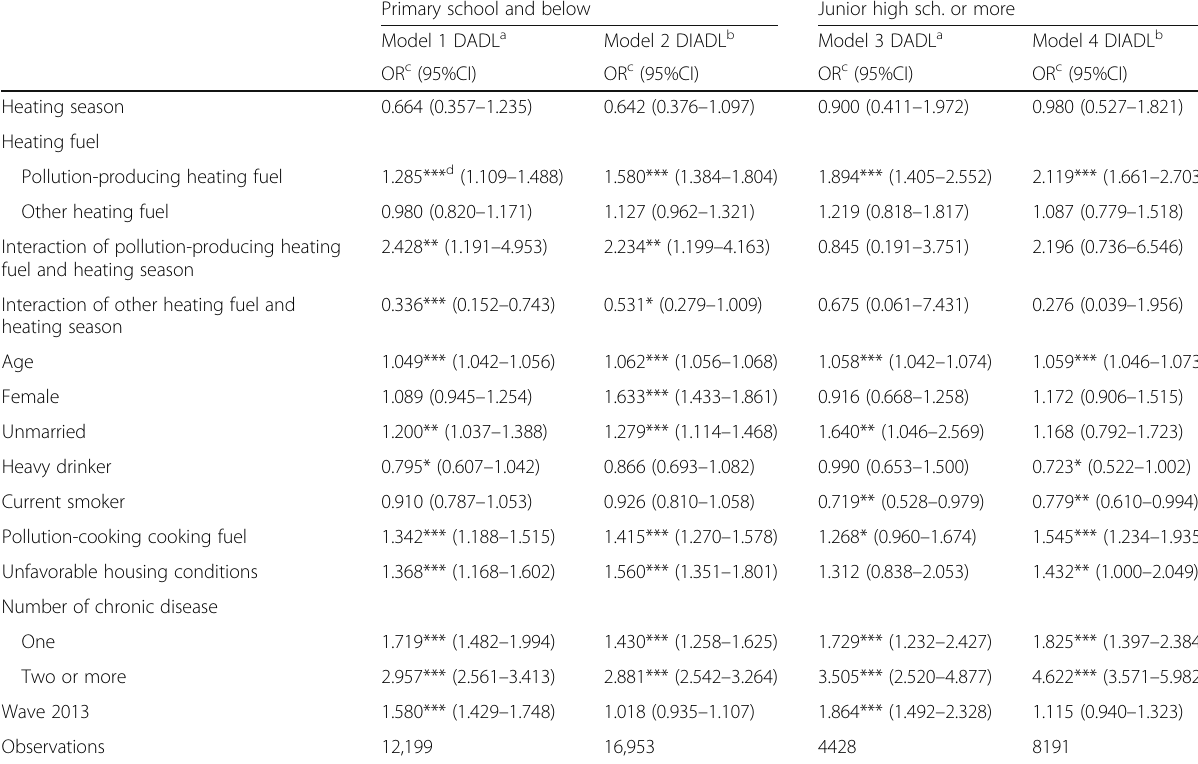
Table 3 Multiple regression analysis of associations between household heating and disability for activities of daily living by education in random effects logit